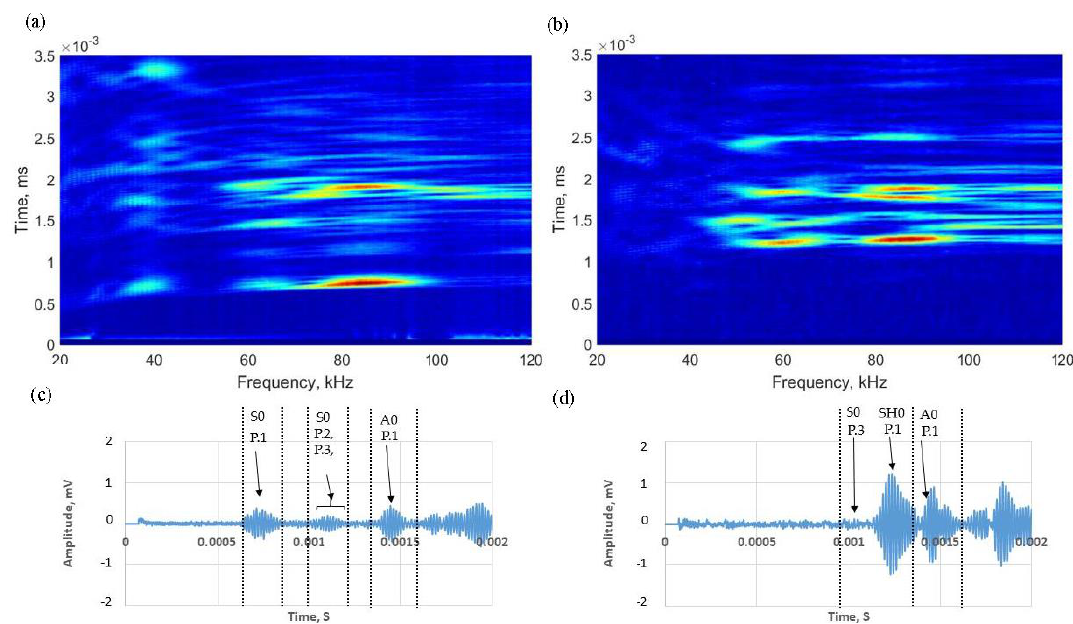
Figure 8. Experimental results: contour plot of the frequency sweep ( a ) in-plane; ( b ) shear transducers attached on the tank floor to excite guided waves for tank floor inspection with corresponding time-domain representation at 60 kHz; ( c ) in-plane; and ( d ) shear.